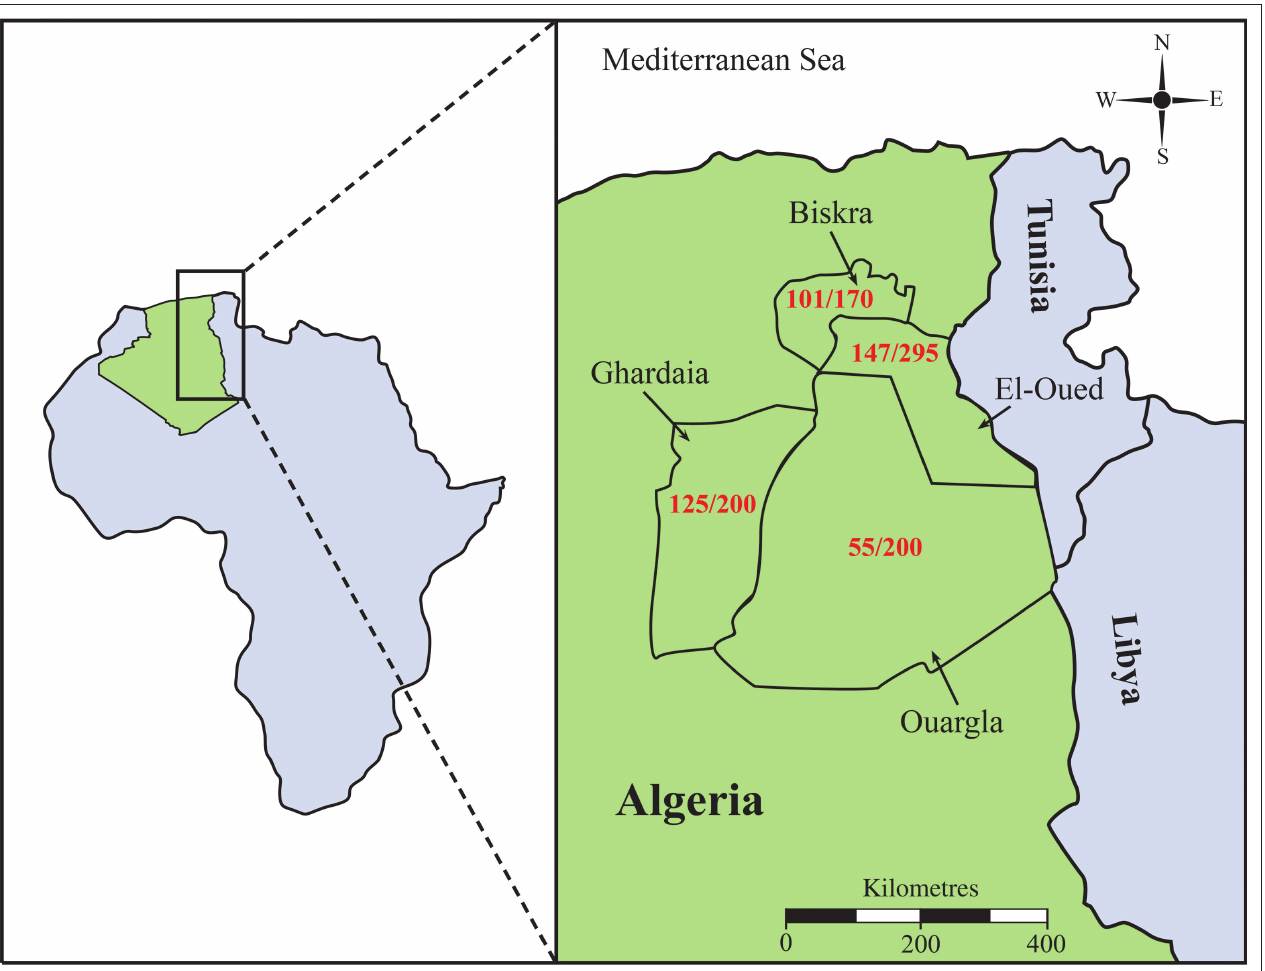
FIGURE 1: Distribution of Trypanosoma evansi seropositivity in dromedary camels in four districts in southeastern Algeria. Numbers in red indicate the number of camels seropositive for Trypanosoma evansi as a proportion of animals tested in the Biskra, El-Oued, Ghardaia and Ouargla